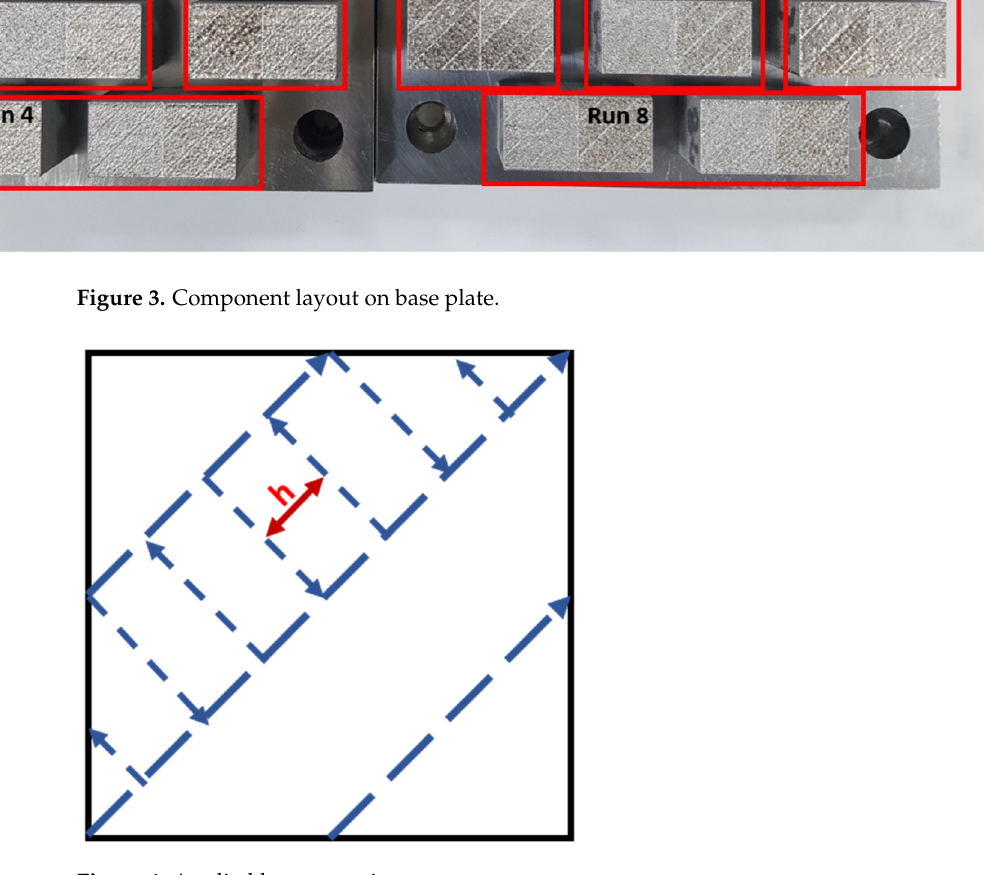
Figure 4. Applied laser-scanning pattern.